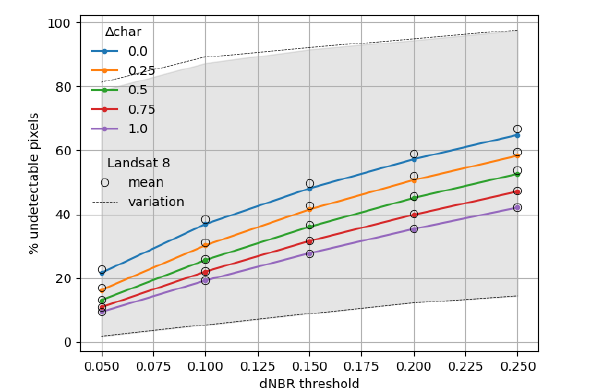
Figure A14. Percentage of undetectable burned pixels as a function of dNBR threshold and ∆ char parameter settings, park-wide for the Moderate Resolution Imaging Spectroradiometer (MODIS). Mean values are shown in colored lines, with total model result variation shown in gray. To compare, the results for Landsat 8 are shown in black, with mean values shown by circles and total model result variation shown by dashed